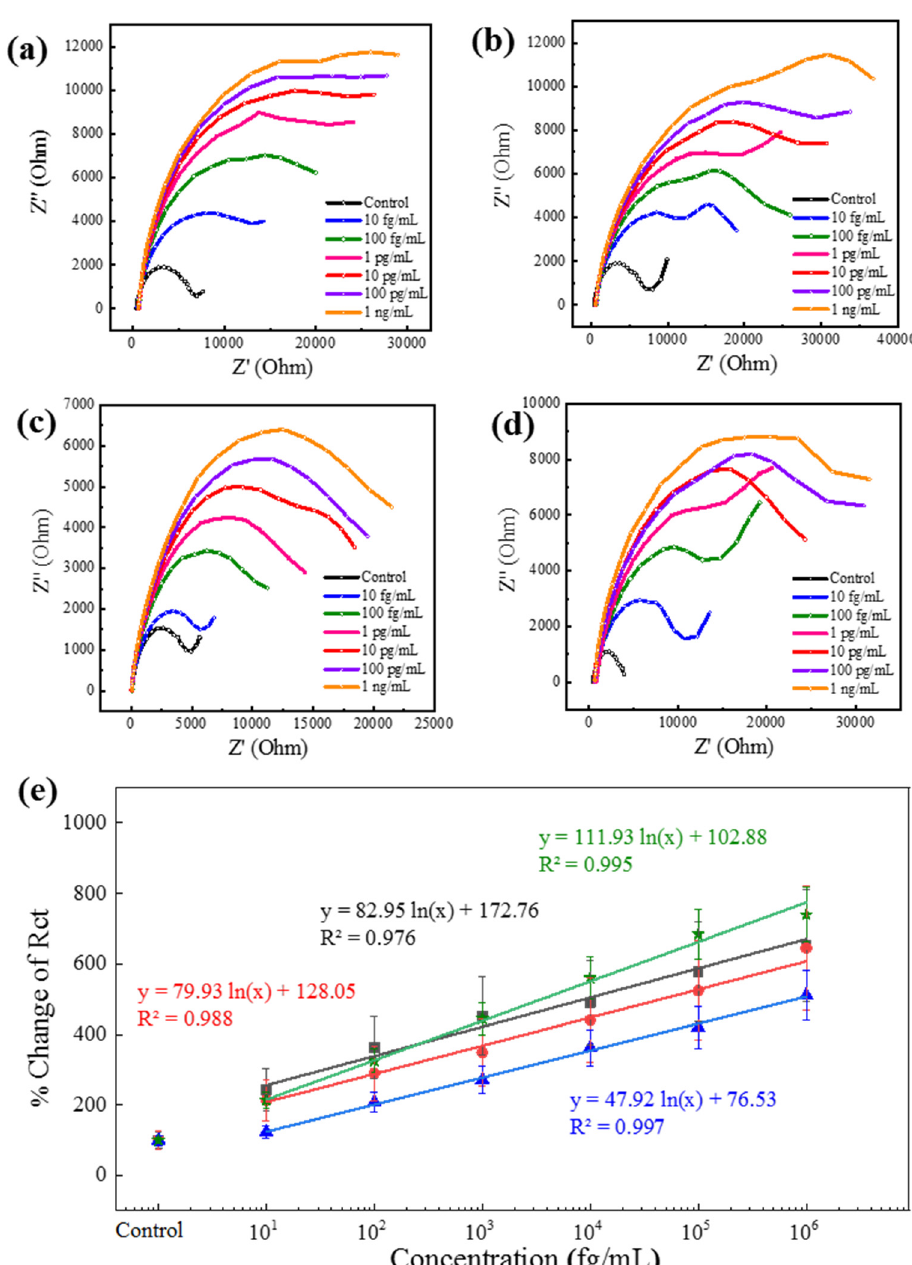
Figure 4. ( a – d ) Nyquist plots of four different DENV-LP serotype antibody-conjugated Au|PAni|Au-PAni-N,S-GQD-Ab DENV electrodes for their corresponding targets in a concentration range from 100 fg mL − 1 to 1 ng mL − 1 . ( e ) Calibration lines for all four serotypes in terms of percentage change in R ct vs. DENV-LP concentration. Symbols: squares for DENV-LP-1; circles for DENV-LP-2; stars for DENV-LP-3; and triangles for DENV-LP-4. Error bars represent the standard deviations of triple measurements.